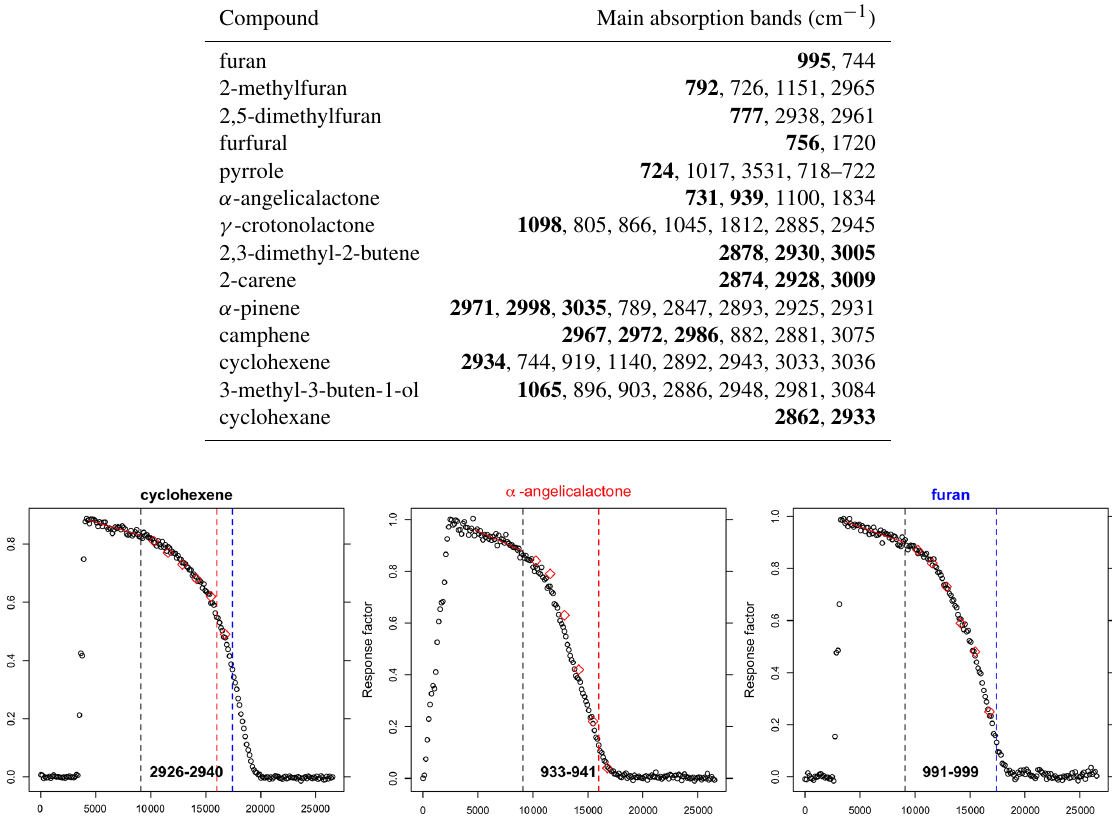
Table 1. Maxima of major absorption bands (of Q branches, if present) for the compounds used in this study. Bands used predominantly for analysis are shown in bold.